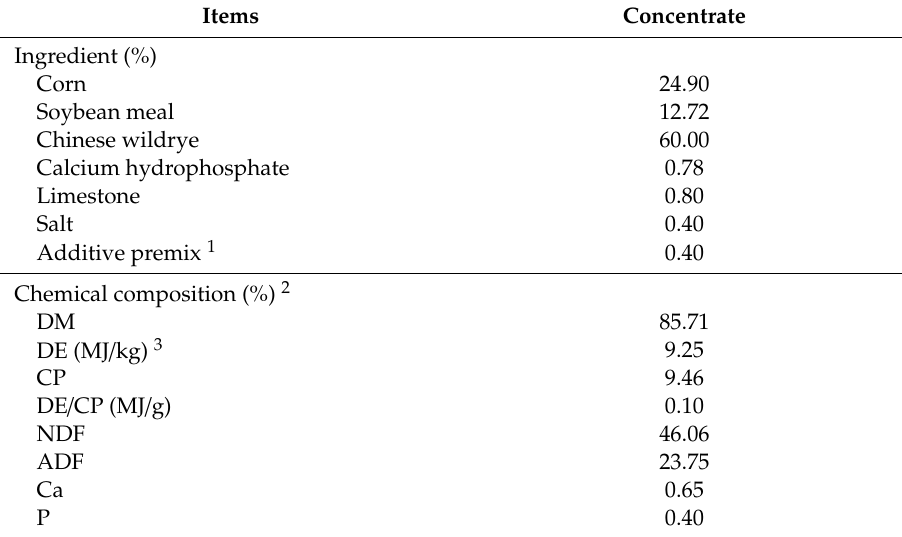
Table 1. Ingredient and chemical composition of the basal